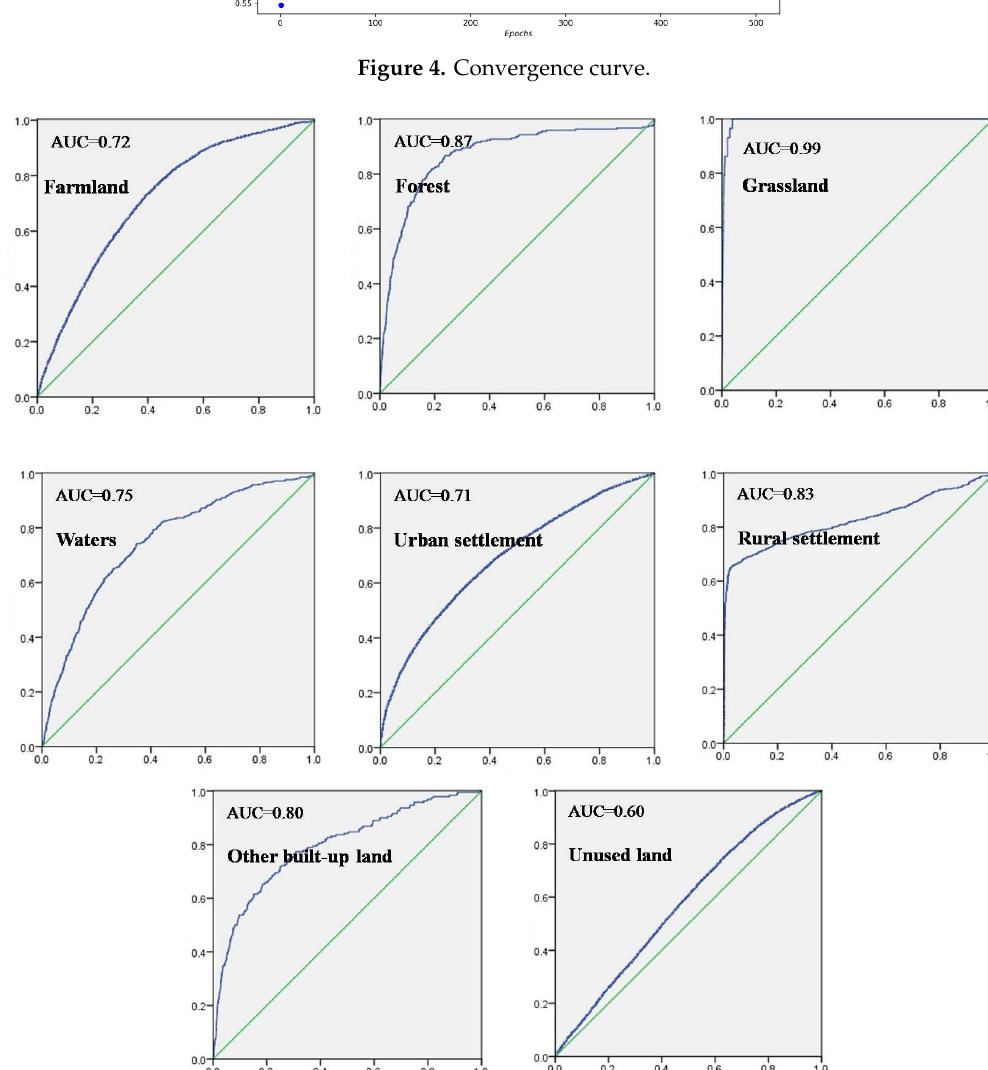
Figure 5. Area under ROC (AUC) value of each land use type.